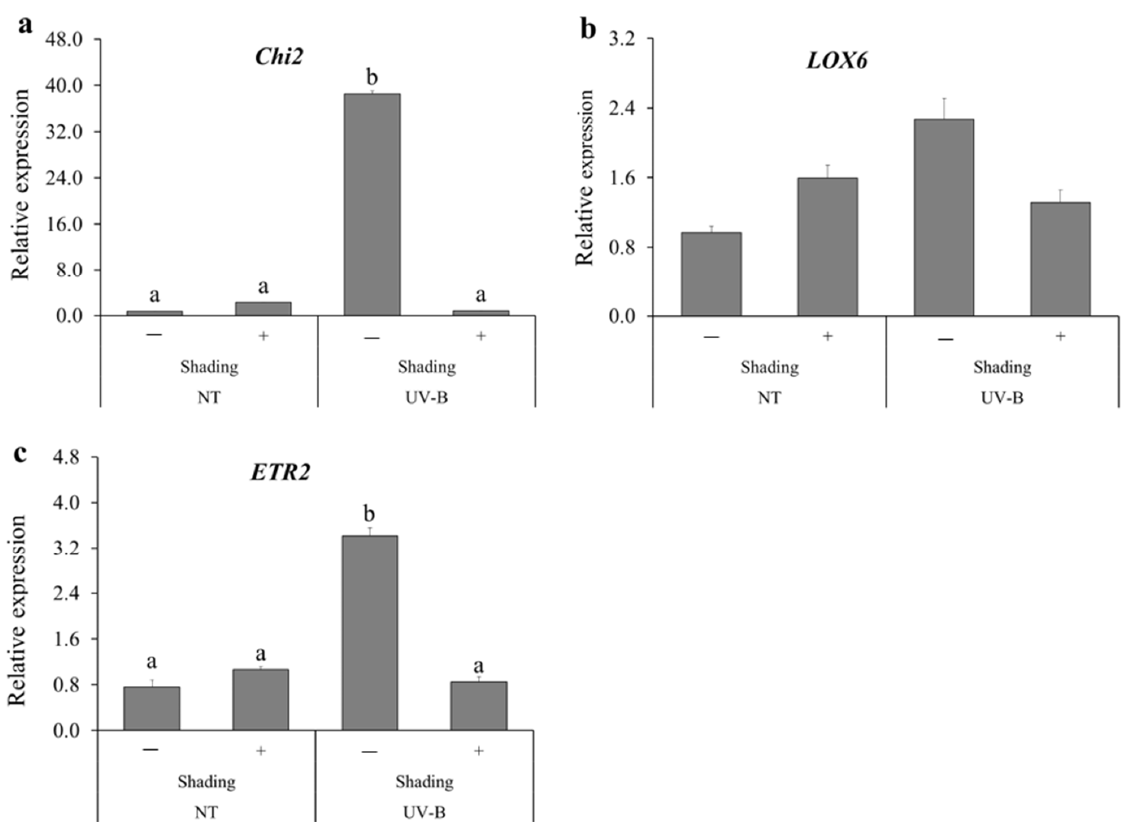
Figure 3. Relative expression levels of Chi2 , ETR2 , and LOX6 in cucumber leaves after partial UV ‐ B treatment. ( a ) Chi2 , ( b ) LOX6 , ( c ) ETR2 . NT: non-treatment; shading +: one of two leaves shaded by aluminum foil, shading − : non-shaded leaf. Different letters above columns indicate a significant difference between treatments. Vertical bars represent the standard error of the mean ( n = 6). The transcript levels of each gene are normalized to Act expression.